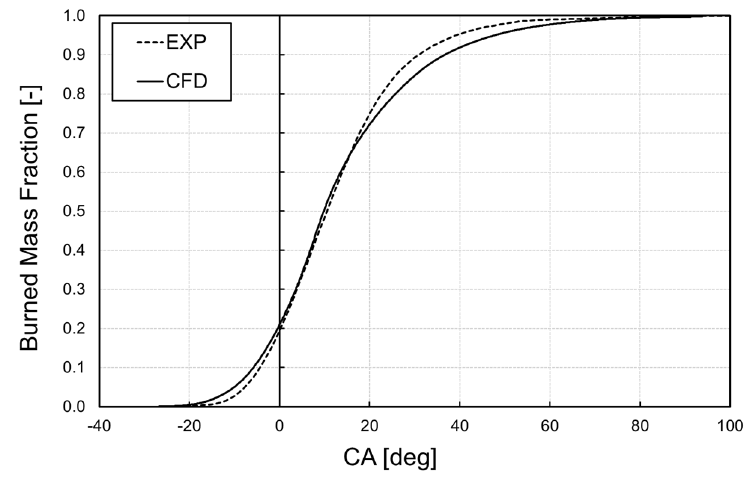
Figure 6. Results of the numerical model calibration: comparison between simulated and measured S-curve in full power conditions.